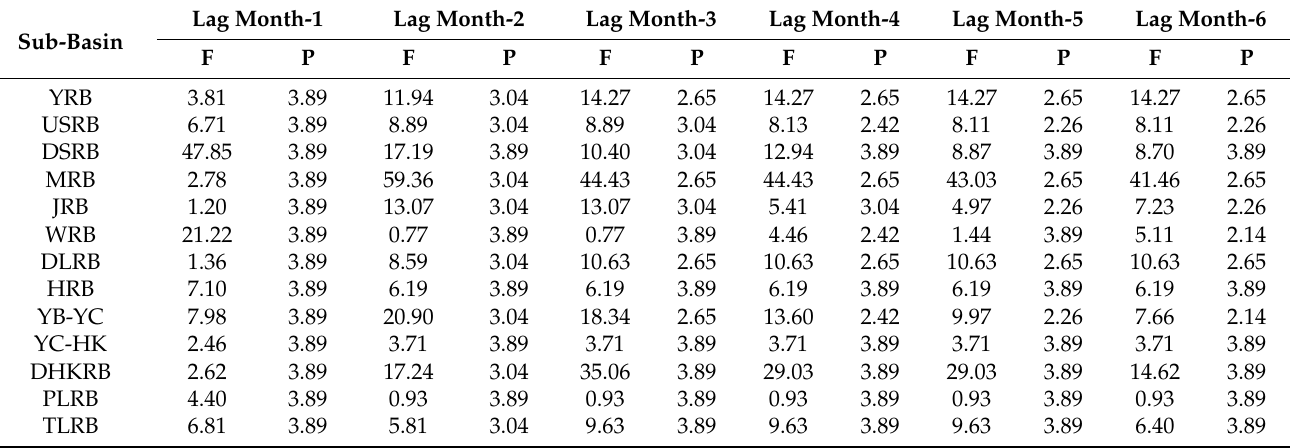
Table 2. Granger’s Causality test between VIC-SMA and GRACE-TWSA in the YRB and its sub-basins at the lags of 1–6 months.